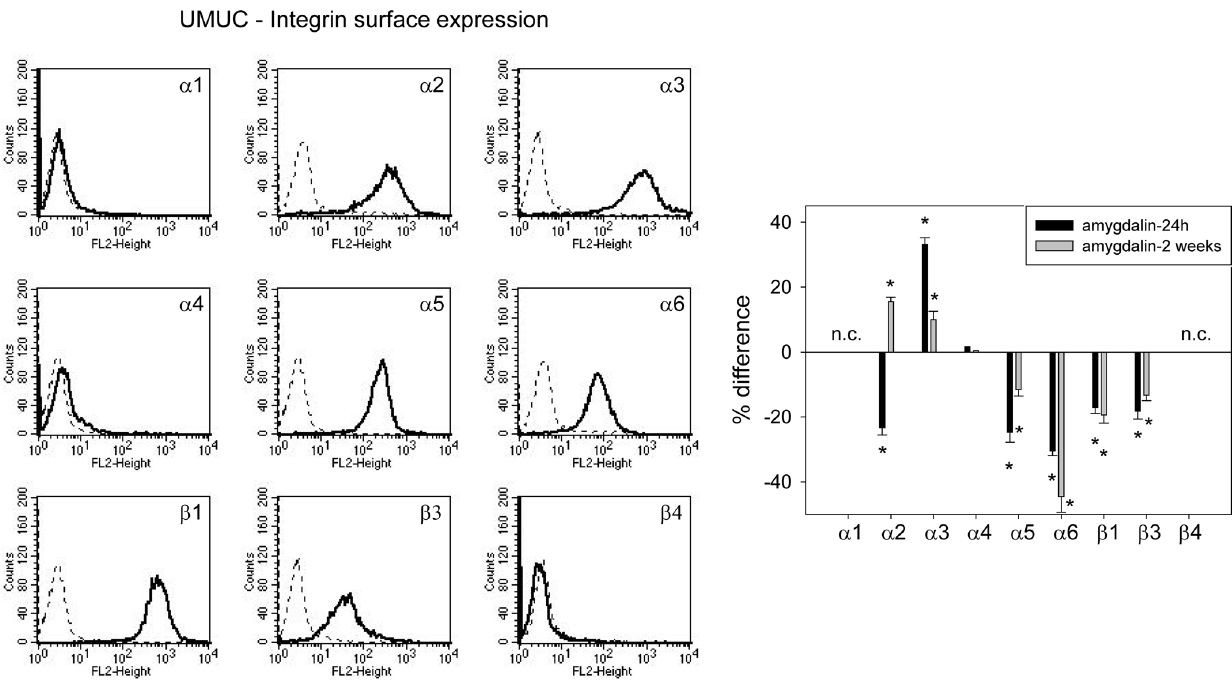
Figure 4. FACS analysis of integrin a and b subtype expression on UMUC-3 cells. The left panel depicts integrin expression as histogram plots with a dotted line indicating background fluorescence and a solid line indicating specific fluorescence in untreated cells. The right panel shows integrin subtype expression after 24 h and 2 weeks amygdalin exposure, compared to controls set at 100%. n.c. = not calculated. * indicates significant difference to controls.